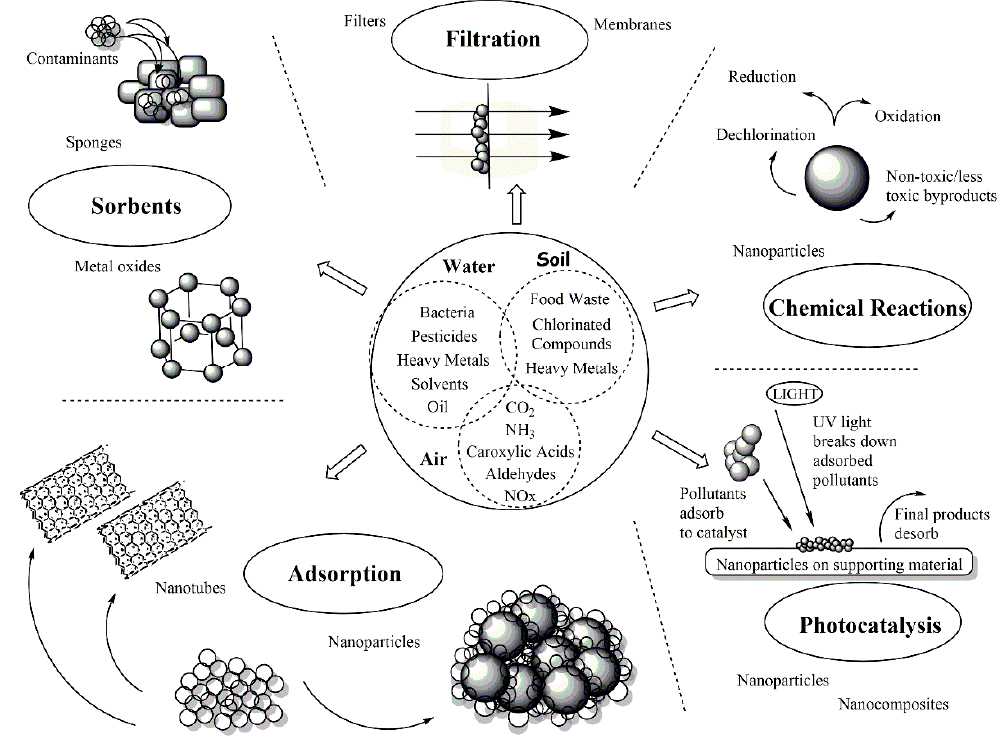
Figure 1. Environmental remediation approaches.